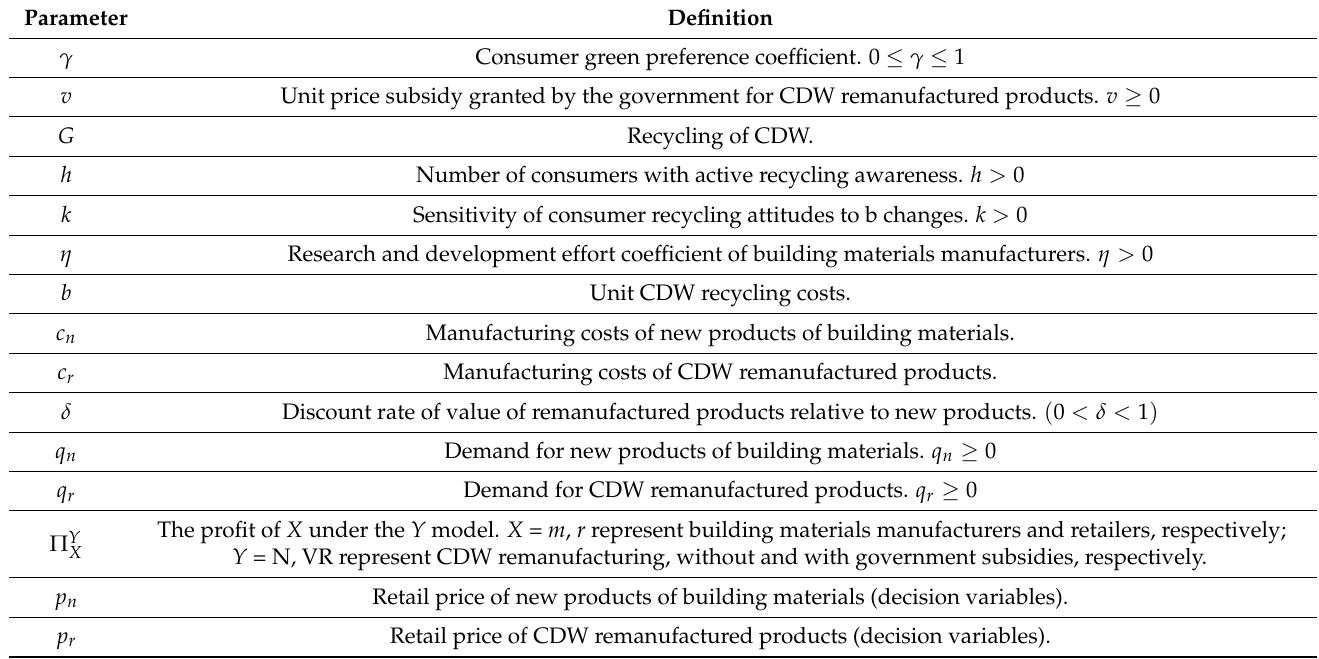
Figure 1. Game model of building materials manufacturer and building materials retailers. Note: VR is the government subsidy for remanufacturing; w n is the wholesale prices for new products of building materials; w r is the wholesale price for CDW remanufactured products; p n is the retail price of new products of building materials; p r is the retail price of CDW remanufactured products. The basic definitions of the parameters used in the study are shown in Table 2. Table 2. Model